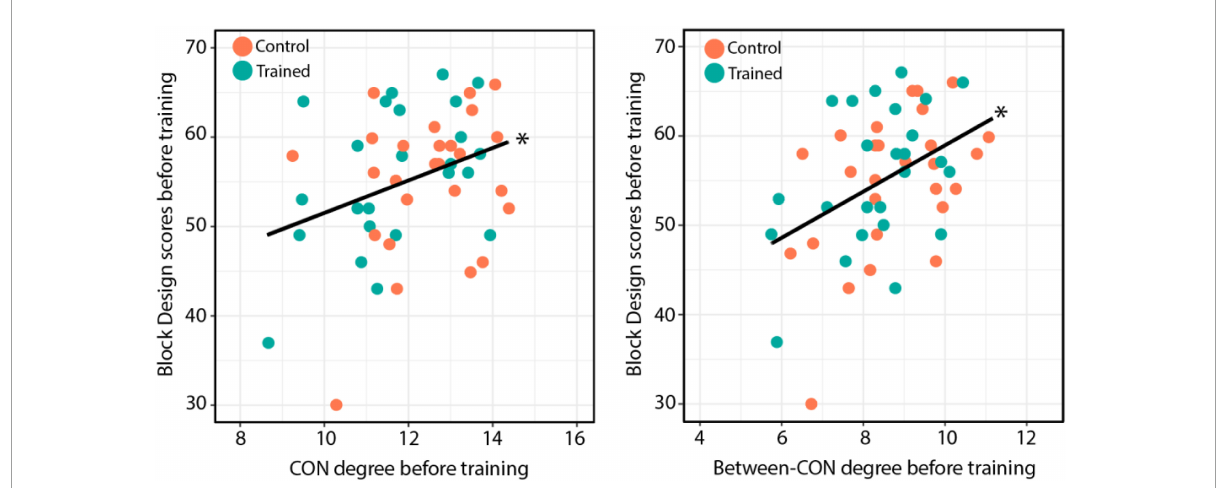
FIGURE7 (Left) Total-CON degree for individual subjects across both groups plotted against Block Design test performance before training. (Right) Between-CON degree plotted against Block Design test performance before training. The results of significance tests are indicated beside the corresponding regression lines (* p <